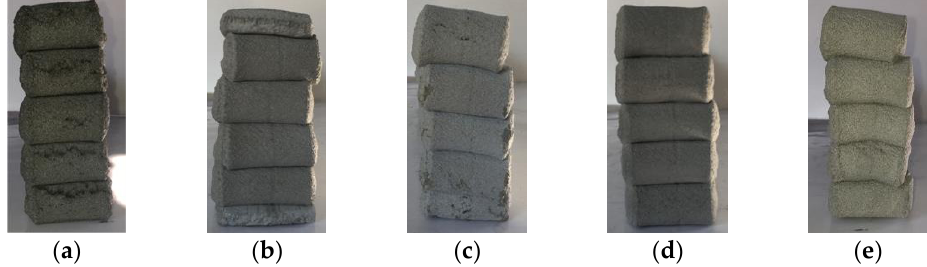
Figure 9. Views of buildability test at 65% flow: ( a ) EVA/cement ratio: 0; ( b ) EVA/cement ratio: 0.05; ( c ) EVA/cement ratio: 0.10; ( d ) EVA/cement ratio: 0.15 and (e) EVA/cement ratio: 0.20.